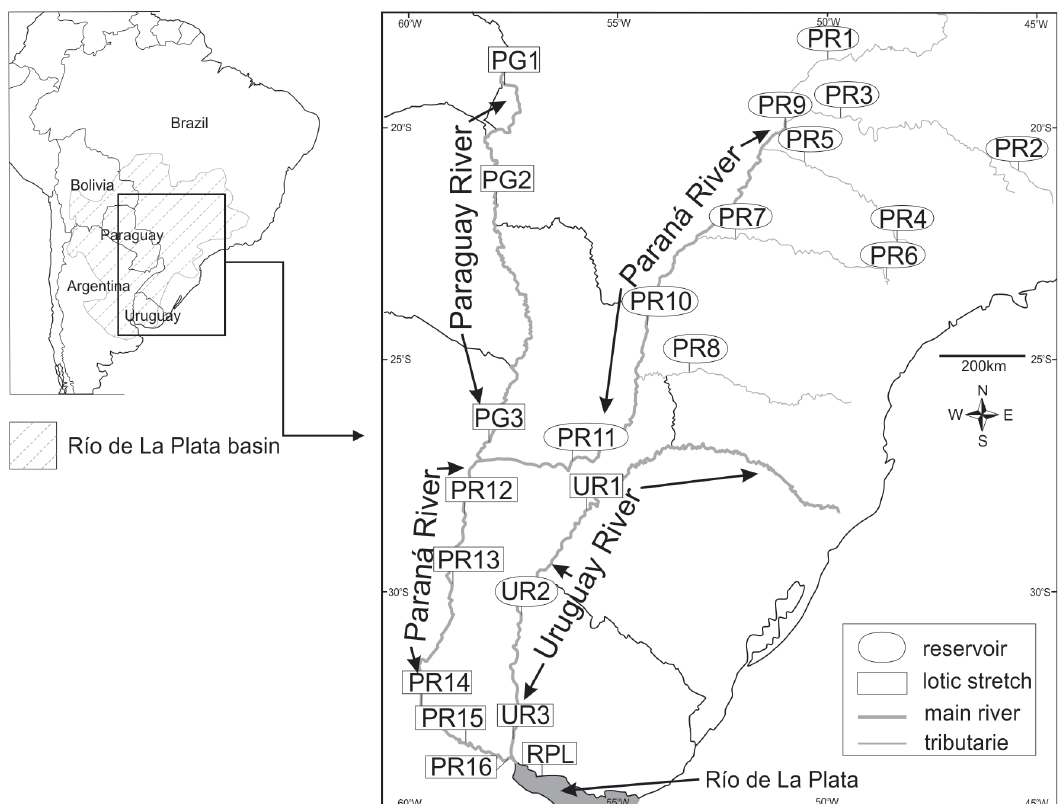
Figure 1. Study area and sampling sites in the Río de La Plata basin (for codes and descriptions see Table